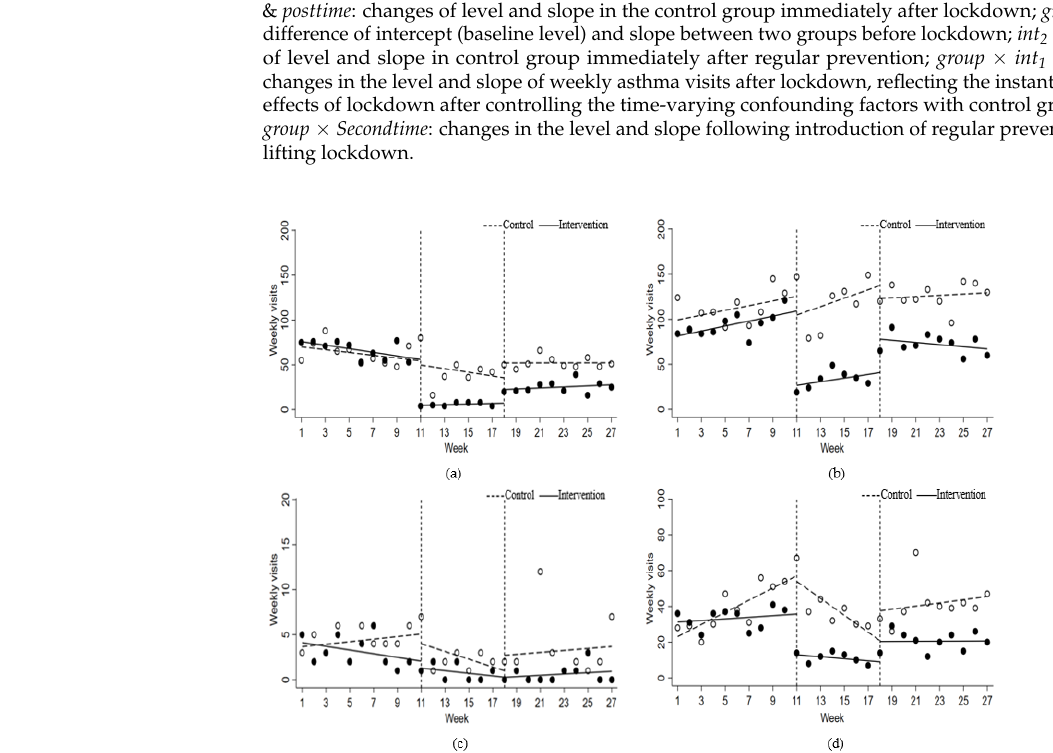
Figure 2. Changes in weekly visits of patients with asthma. ( a ) GOPD visits among children with asthma; ( b ) GOPD visits among adults with asthma; ( c ) ED/ICU visits among children with asthma; ( d ) ED/ICU among adults with asthma.